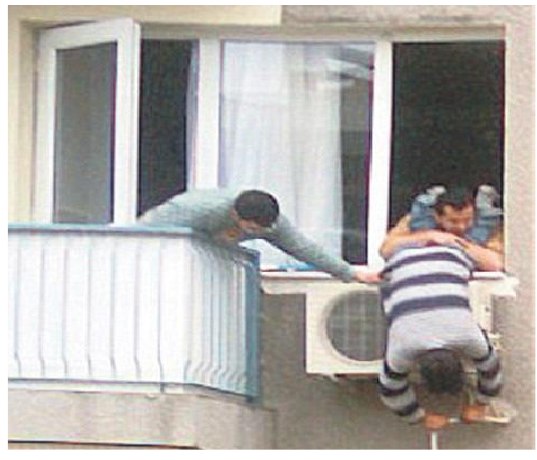
Figure 3. Air conditioner technicians risking lives to install units. (Source: Online Mail Newspaper, 24